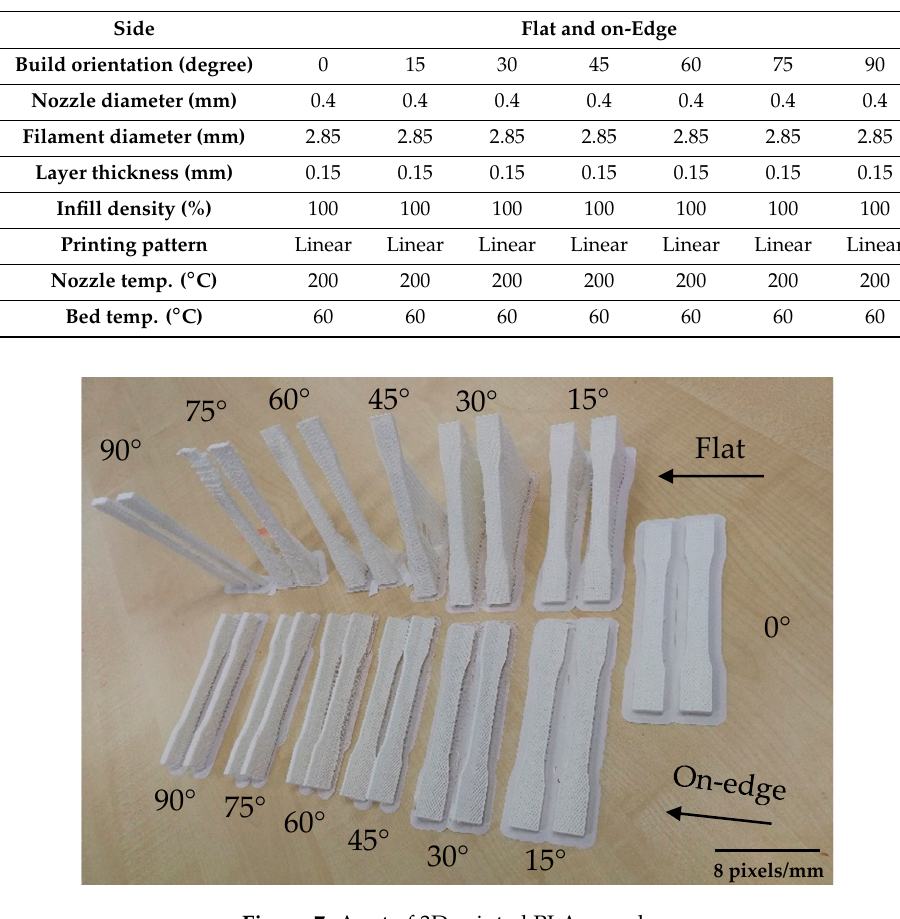
Figure 7. A set of 3D printed PLA samples.